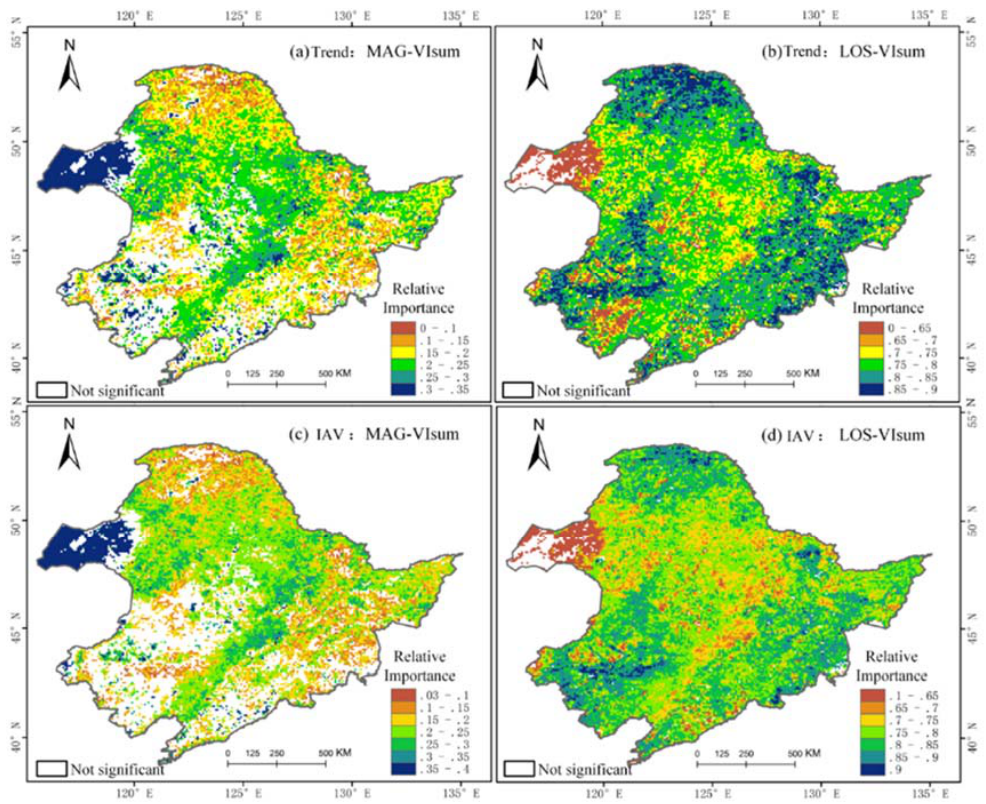
Figure 7. Spatial distribution of relative importance of MAG and LOS to long ‐ term trends ( a , b ) and inter ‐ annual variability (IAV) ( c , d ) of vegetation production (significance level: p value < 0.05).